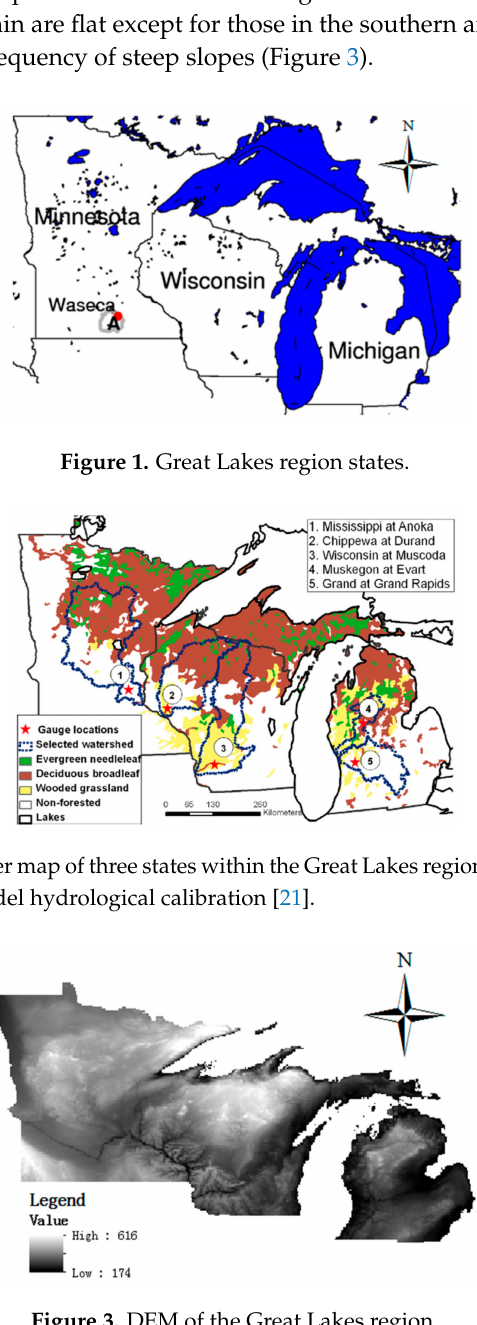
Figure 3. DEM of the Great Lakes